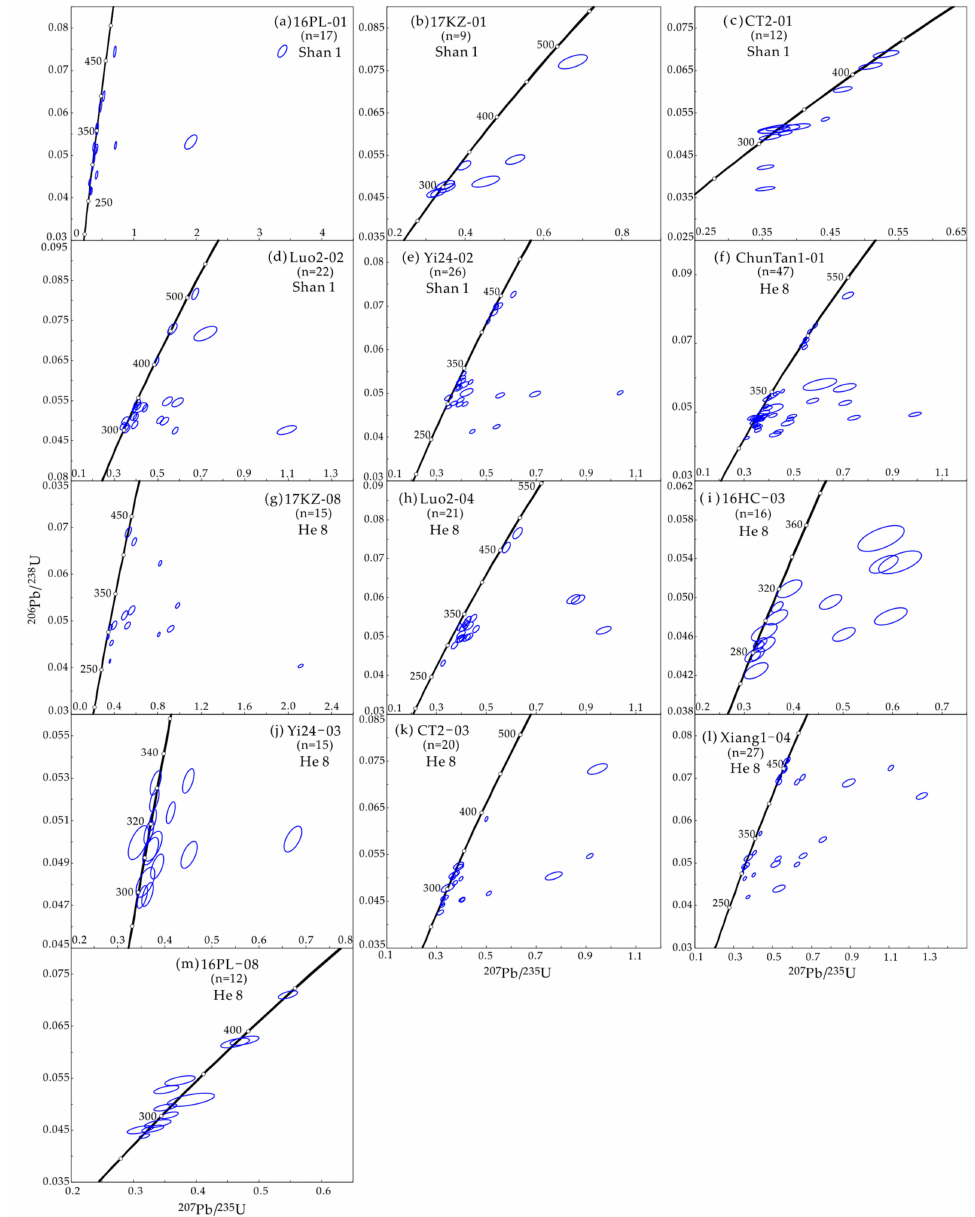
Figure 5. U-Pb concordia diagrams of 520–260 Ma detrital zircons. Errors are quoted at the 1 σ